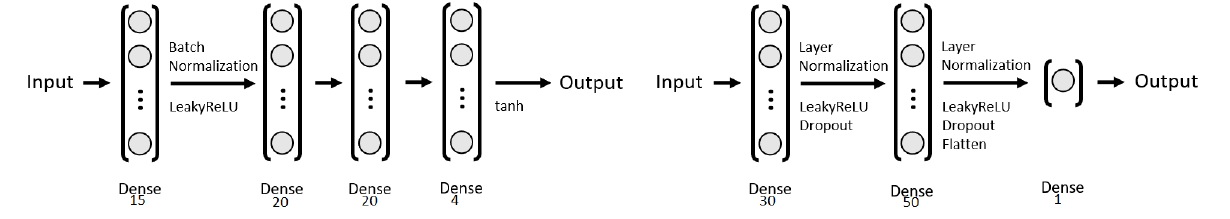
Figure 22. The structure of the generator ( left ) and critic ( right ) for modelling the silver data in this section.